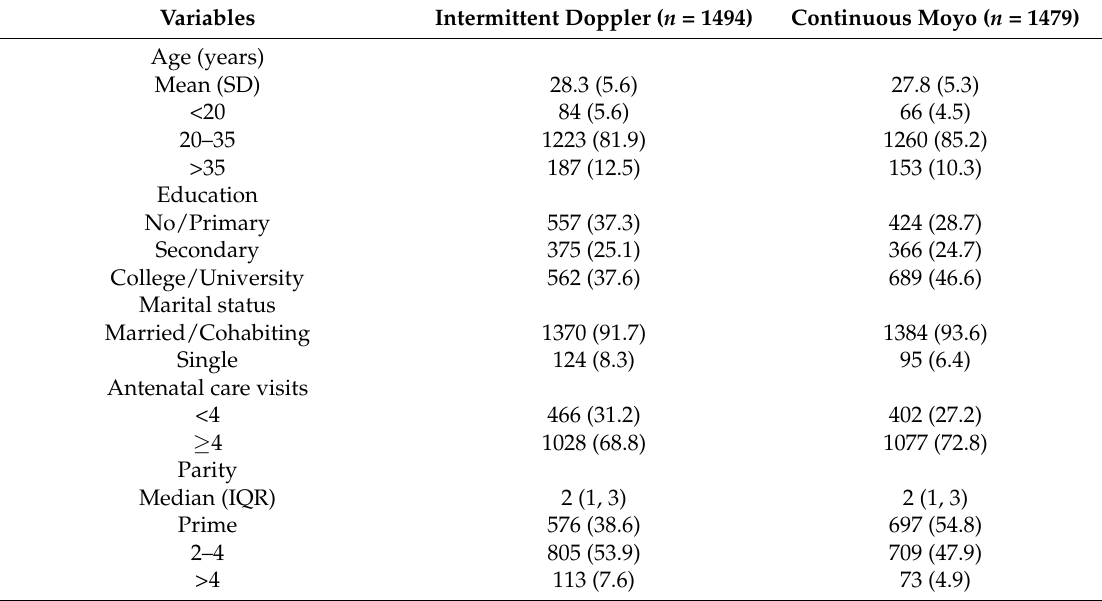
Table 1. Baseline demographic, clinical, and perinatal characteristics of randomized low risk pregnant women in labour.